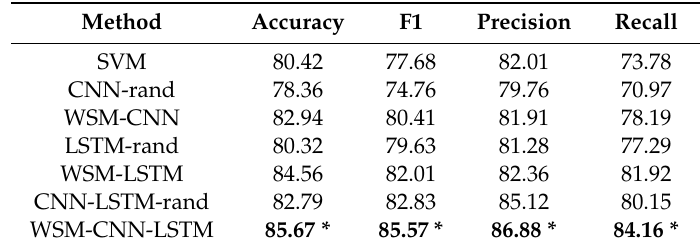
Table 3. ADR identification performance percentages when testing di ff erent compared models. Stratified 10 × 10-fold cross validation results.